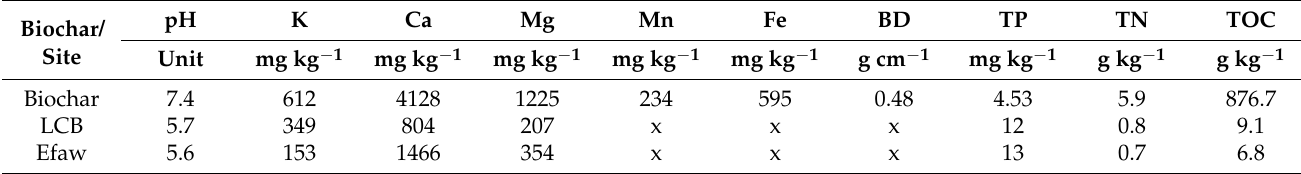
Table 1. Physical and chemical properties of soft wood (Southern Yellow Pine) biochar supplied by Wakefield Biochar, Columbia, Missouri; the initial soil chemical properties at Lake Carl Blackwell (LCB) and Efaw research sites, Stillwater, OK, USA.